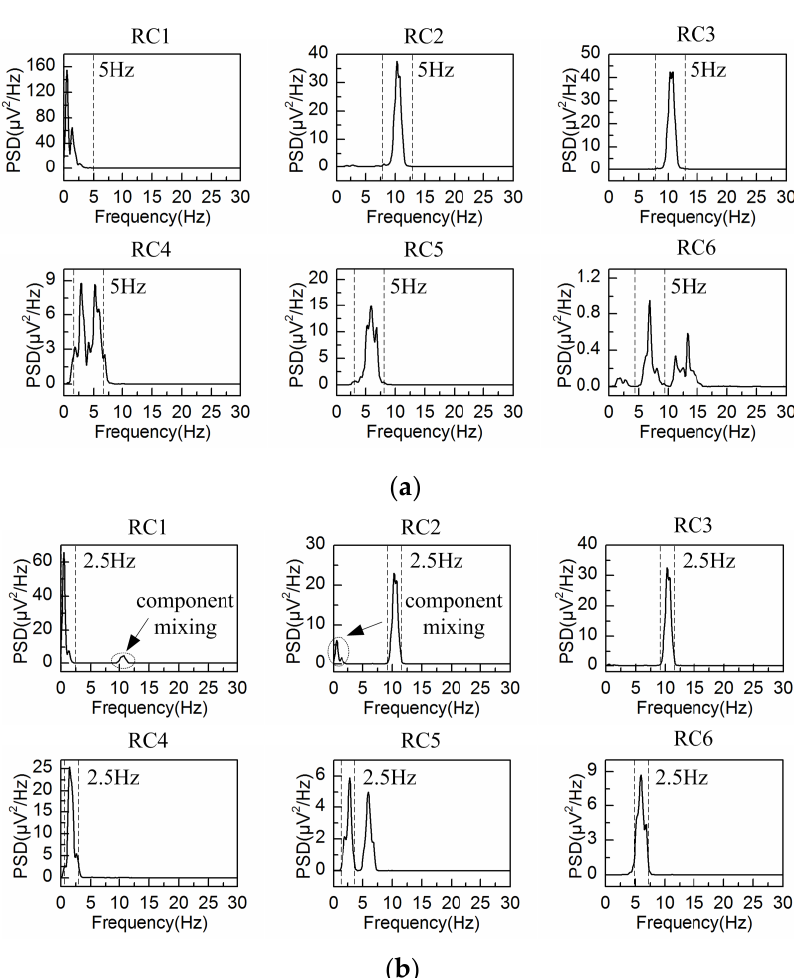
Figure 5. Extracting the alpha rhythm from the simulated EEG signal by different embedding dimensions L: ( a ) the simulated EEG signal; ( b ) ε ave corresponding to different embedding dimensions L.